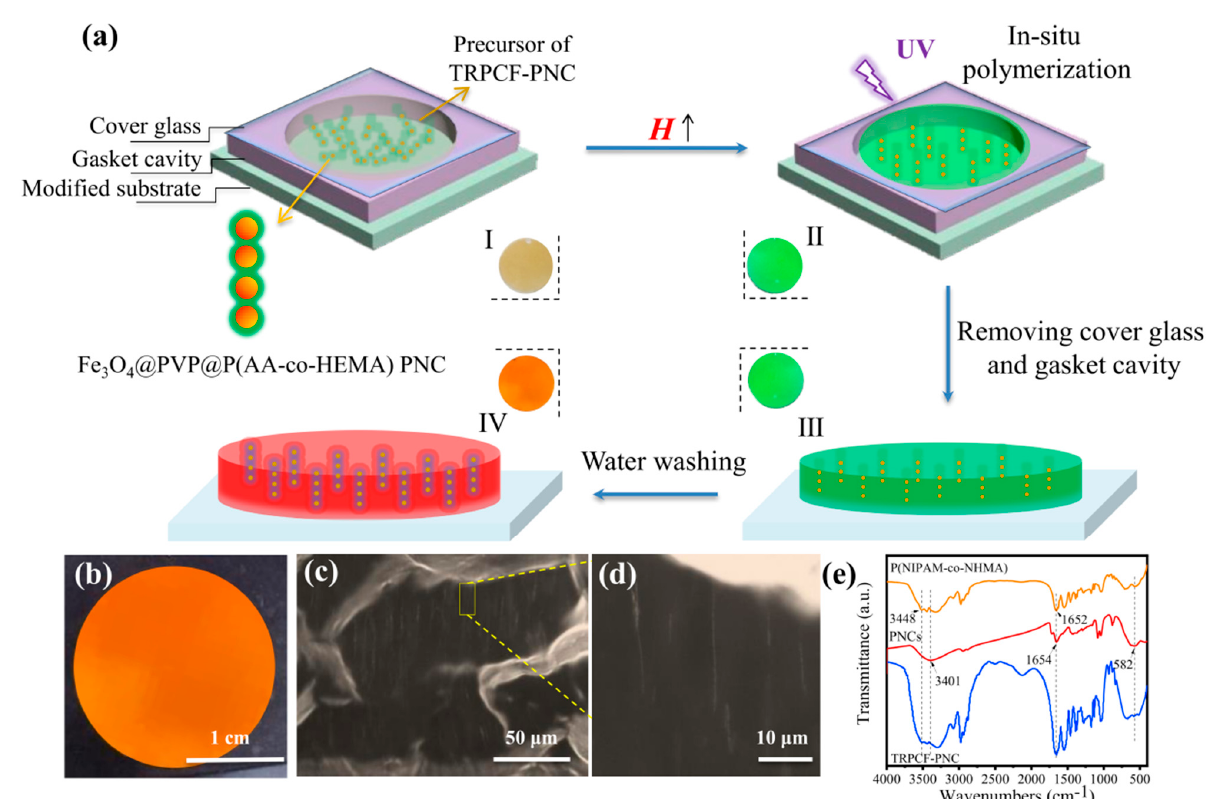
Figure 1. ( a ) A schematic diagram of the preparation process of the thermo-responsive photonic crystal film based photonic nanochains (TRPCF-PNC). First, a precursor solution containing photonic nanochains (PNCs) was injected into the gasket cavity clapped between a double-bond modified glass substrate and a cover glass. Then, the whole sample was placed in a uniform magnetic field to induce the alignment of PNCs, followed by UV curing. The TRPCF-PNC was eventually obtained after removing the cover glass and gasket cavity, which were then washed. The digital photos of the four states of the TRPCF-PNC in different procedures of preparation are presented correspondingly (I to IV). ( b ) Digital photo, ( c ) cross-section, and ( d ) locally magnified optical microscopy images of typical TRPCF-PNC. ( e ) FTIR spectra of the different samples.